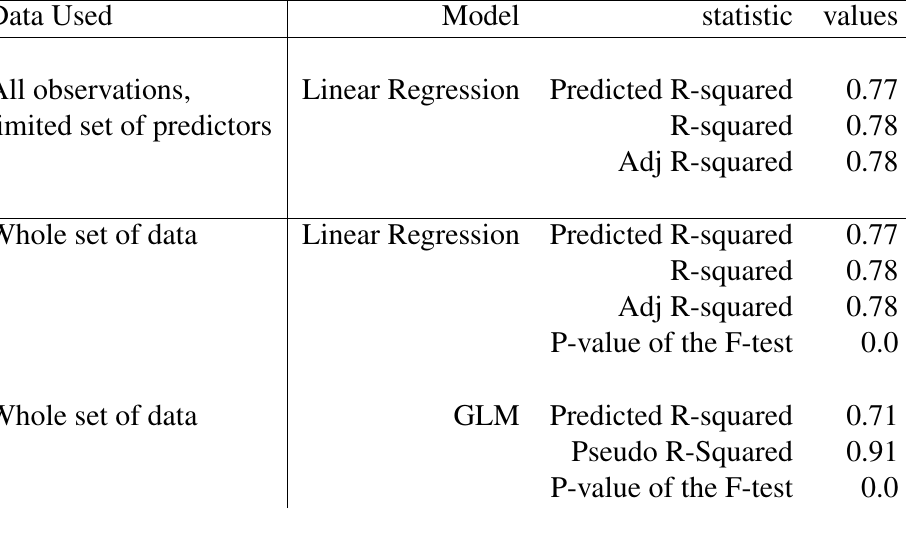
Table 5: Linear Regression and GLMs over the whole set of data: measures of the goodness of the